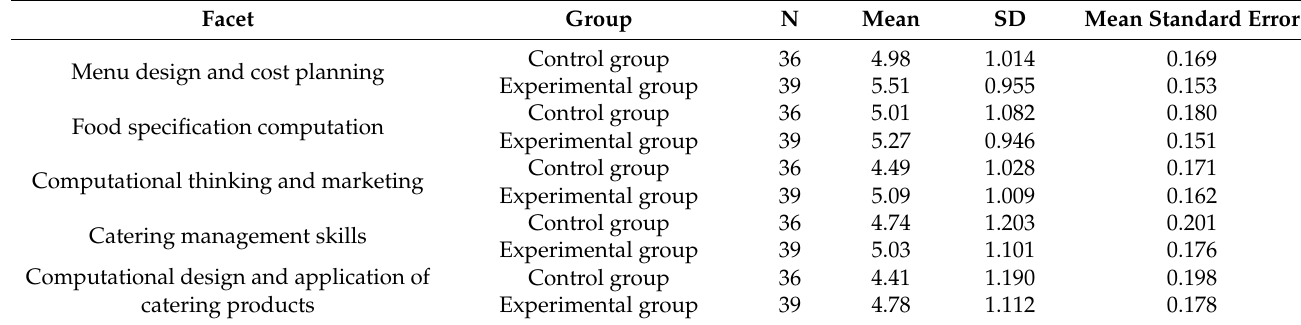
Table 7. Group statistics and summary of the independent-sample t -test results for the posttest scores of the two groups.